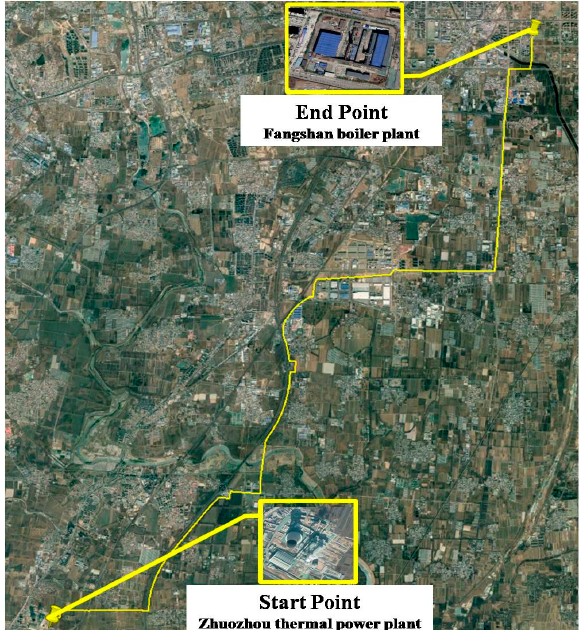
Figure 10. The manually selected heating route.